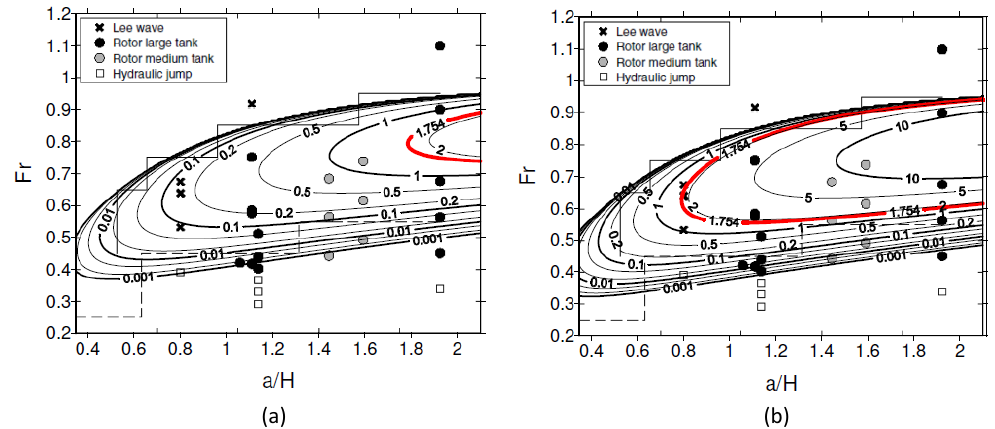
Figure 4. ( a ) and ( b ) should replace Figure 8a,b in [1].